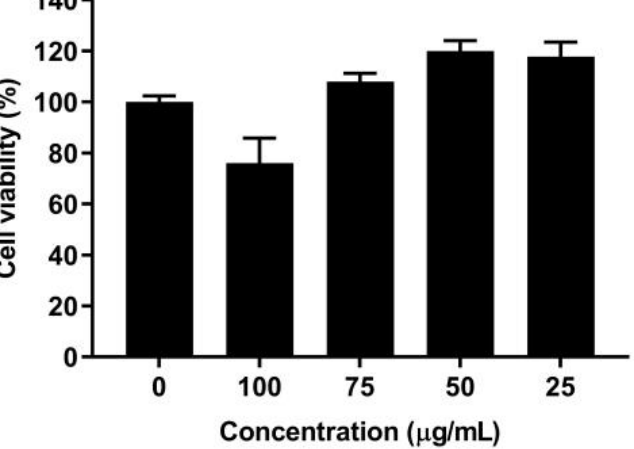
Figure 1. Effect of Maackia amurensis branch extract on B16F1 melanoma cell viability. B16F1 melanoma cells were treated with various concentrations of M. amurensis branch extract. M. amurensis branch extract did not show cytotoxicity at concentrations of ≤ 75 µ g/mL. Data are presented as mean ± standard deviation (SD) of three independent experiments.